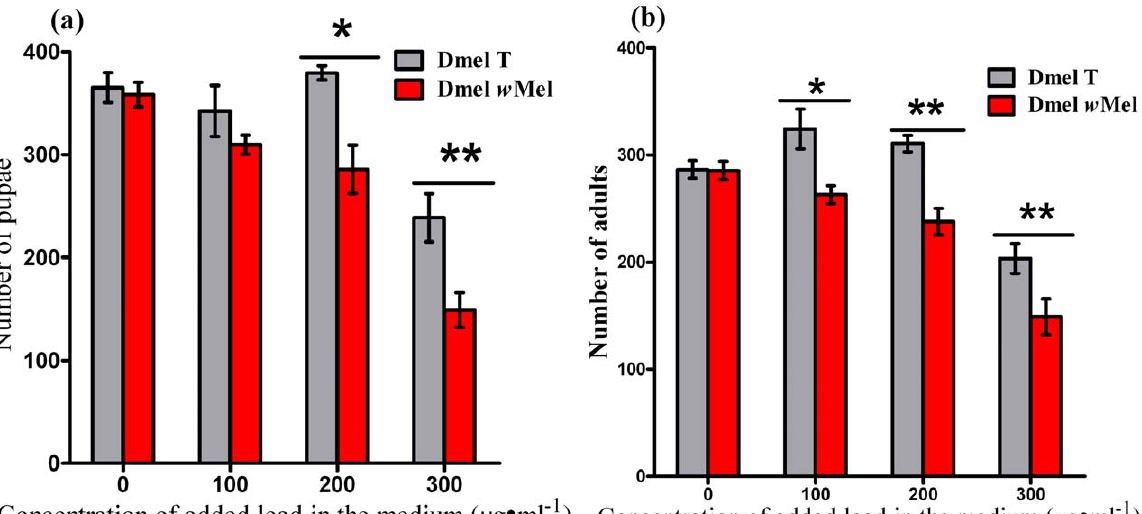
Figure 1. Influence of Wolbachia infection on survival of Drosophila reared in Pb-contaminated medium. ( a ) Number of pupae of Dmel w Mel and Dmel T emerged from each group. ( b ) Number of adults of Dmel w Mel and Dmel T emerged from each group. Bars=standard error; ‘‘*’’ indicated P , 0.05; ‘‘**’’ indicated P , 0.01.